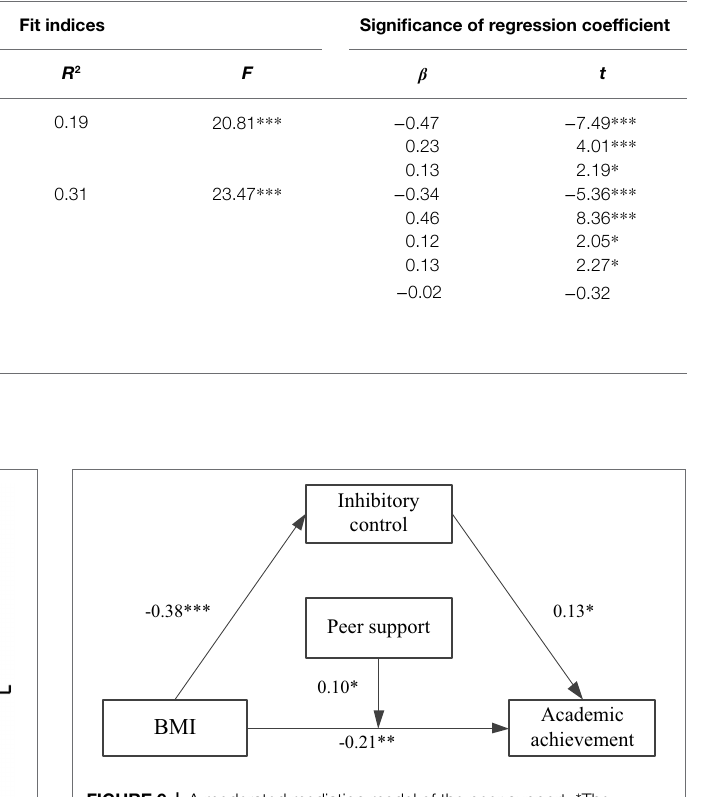
FIGURE 9 | A moderated mediation model of the peer support. *The correlation is significant at the 0.05 level. **The correlation is significant at the 0.01 level. ***The correlation is significant at the 0.001 level.